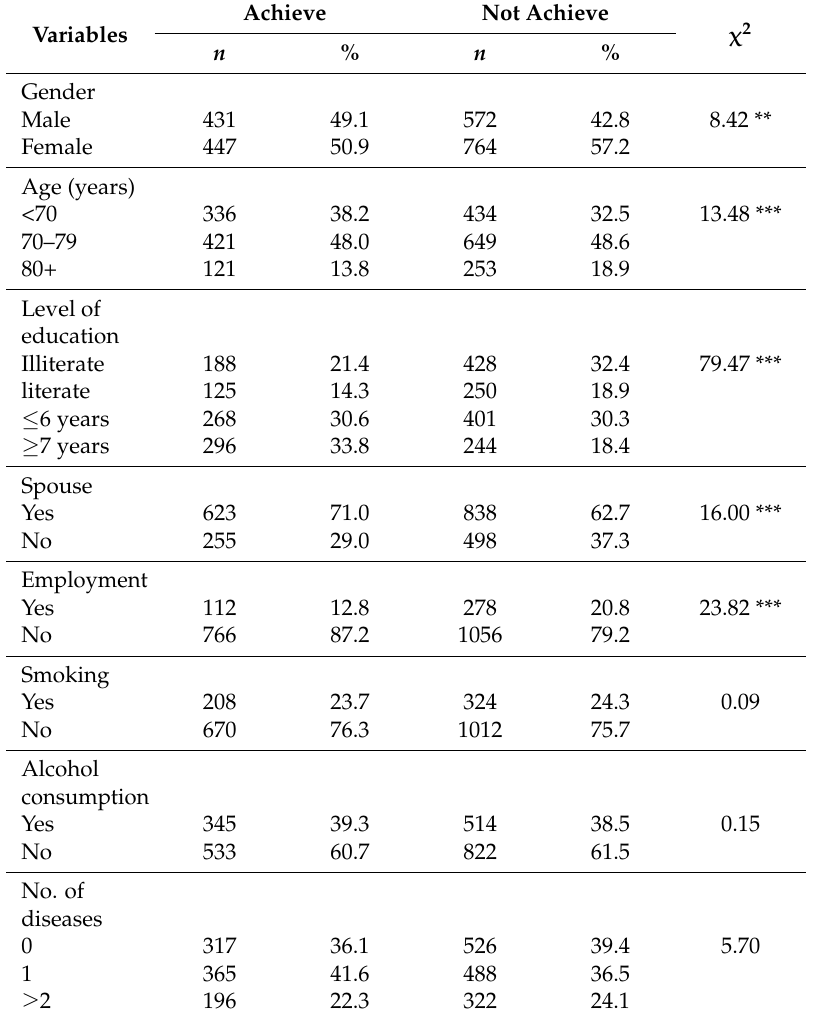
Table 4. Factors associated with the recommended amount of PA among older adults in Taiwan. Achieve Not Variables